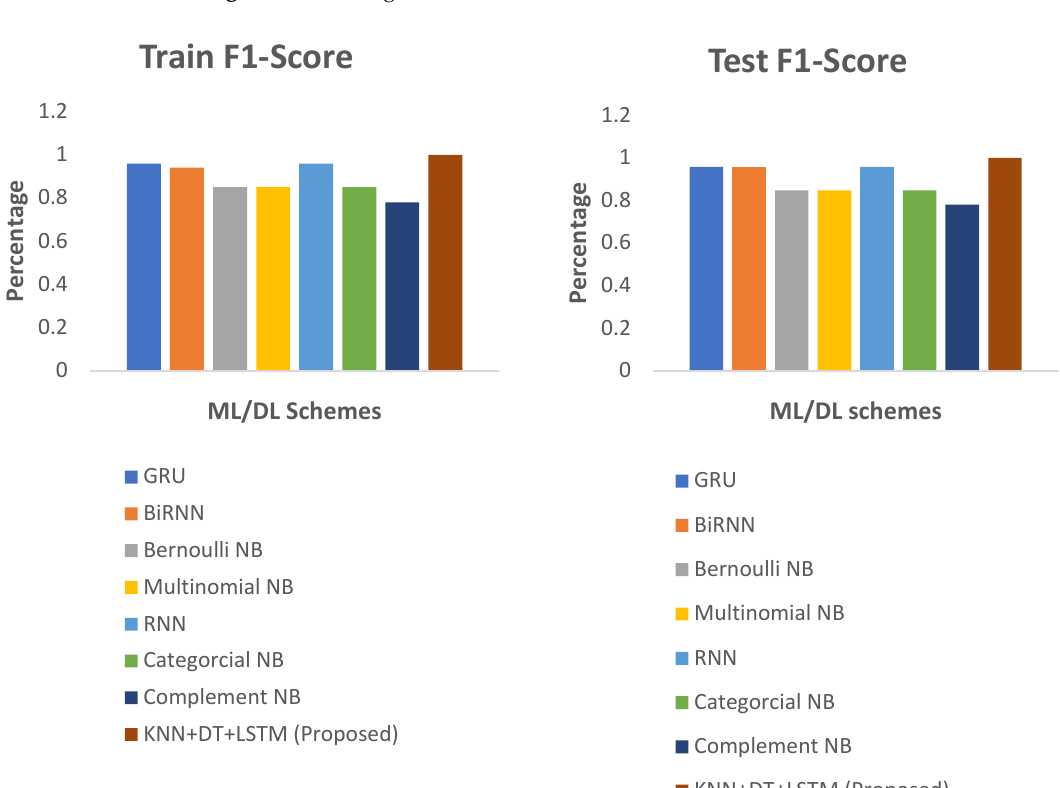
Figure 15. Training and Test F1 Scores of Different Models. Table 2. Performance Metrics of Different ML/DL Models (Training).